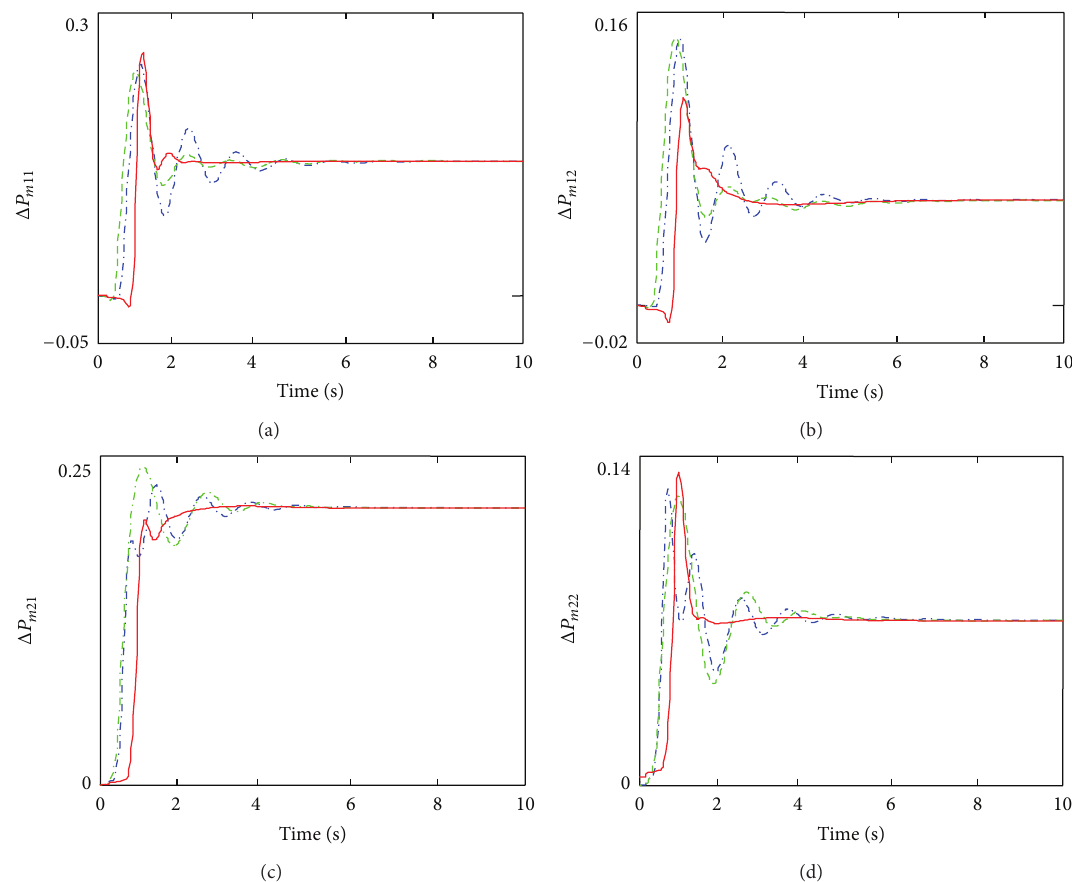
Figure 6: Power after any GENCO in nominal load; Solid (IABC-F), Dashed (PSO-F), and Dashed Dotted (GA-F).